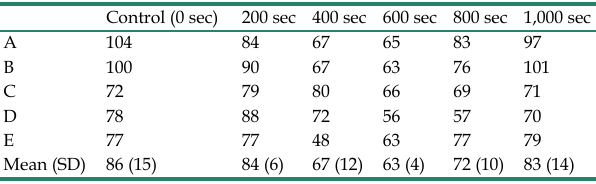
Table 1. Colony counts per test sequence